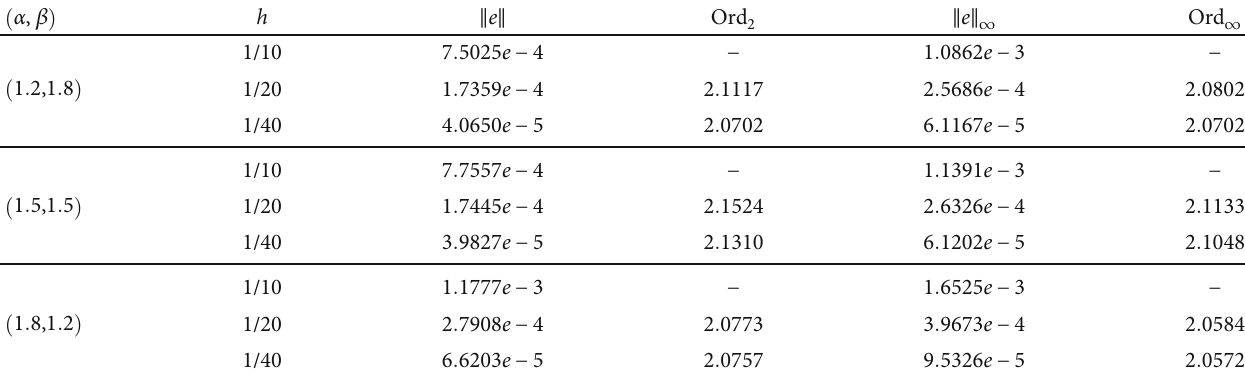
Table 1: l 2 - and l ∞ -errors and their convergence orders of (28) – (30) for 1 < α < 2 in the spatial direction for (72) with fi xed time step τ = 1/2000 for Example 1.